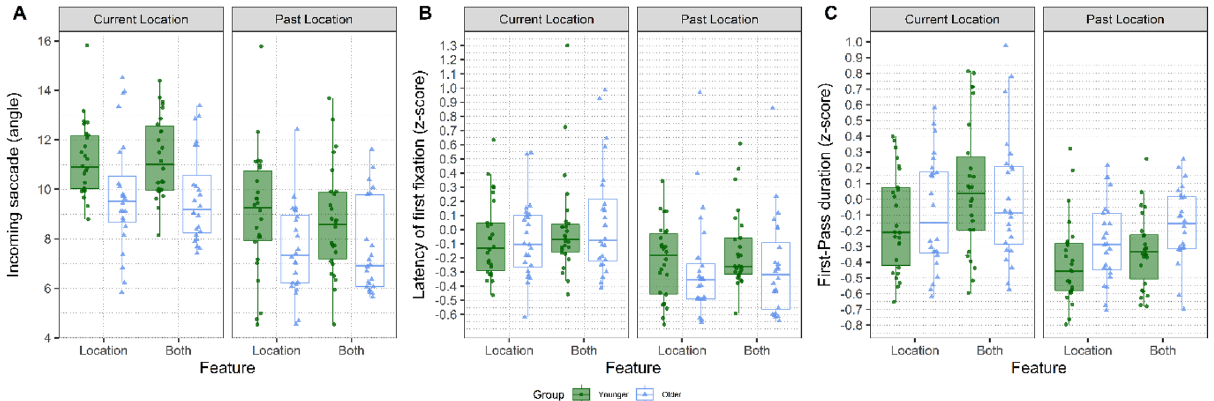
Figure 7. Eye-movement measures comparing Current and Past Location: Here, we focus our comparison between the two conditions that involved a change in location of the target object (Location, Both). Current Location is where the object is now displayed in the recognition phase. Past location instead is where the target object was during the study phase. ( A) Incoming saccade amplitude of the first fixation to the critical object in degrees of visual angle, ( B ) Latency of the first fixation on the critical object (z-scores), and ( C ) the sum of all fixations on the critical object before exiting it for the first time (First-Pass, also in z-scores). The Current Location and the Past Location are compared side-by-side and two Groups of participants within each panel. The Younger group is depicted in green, whereas the Older group is depicted in blue. The hinges of the boxplots represent the 25th and 75th percentiles of the measure (lower and upper quartiles). The horizontal line represents instead the median of the distribution. Each dot indicates the by-participant average for that